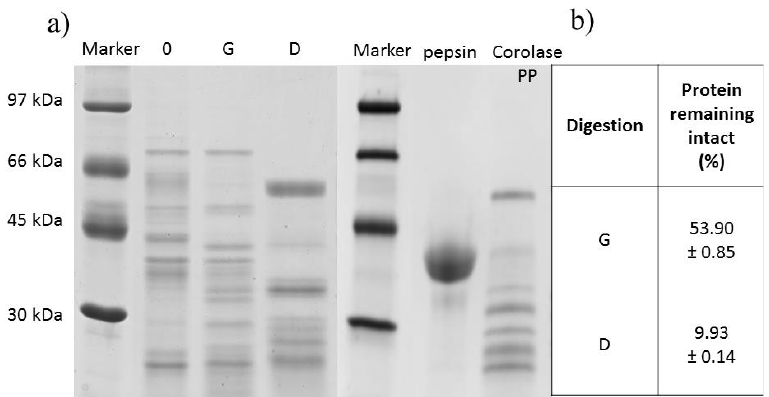
Figure 1. Analysis of oat kernel proteins after in vitro human-like gastrointestinal digestion. ( a ) Electrophoretic separation (SDS-PAGE) of digests of oat kernel proteins and digestive enzymes. ( b ) The percentage of protein remaining intact after digestion of oat kernel proteins. Mass marker (30 – 97 kDa), 0 — intact sample, G — digest after 2 h gastric phase, D — digest after 2 h duodenal phase (see Materials and Methods).